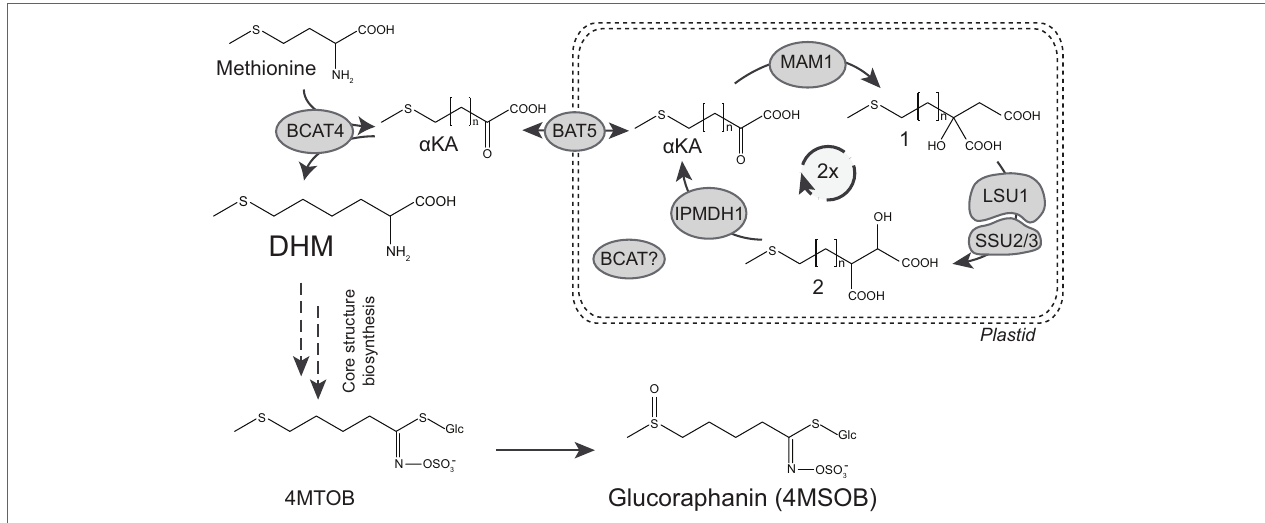
FigUre 1 | Biosynthetic pathway of dihomomethionine and glucoraphanin in Arabidopsis . Glucoraphanin biosynthesis consists of three steps: methionine conversion to dihomomethionine (DHM) by two cycles in the chain elongation machinery. Followed by DHM conversion into 4-methylthiobutyl glucosinolate (4MTOB) by the core structure pathway, and finally conversion of 4MTOB into 4-methylsulfinyl GLS (4MSOB), commonly known as glucoraphanin. Structures for intermediates of methionine chain elongation are depicted with DHM as the desired intermediate for the formation of glucoraphanin. α KA = α -keto acid, methylthio malate intermediates after condensation (1) and after isomerization (2). n = number of additional methylene groups in the methionine side chain as a result of the condensation reaction in the chain elongation cycle: n = 1 for methionine, n = 2 and n = 3 for intermediates from the first and second side-chain elongation cycle,